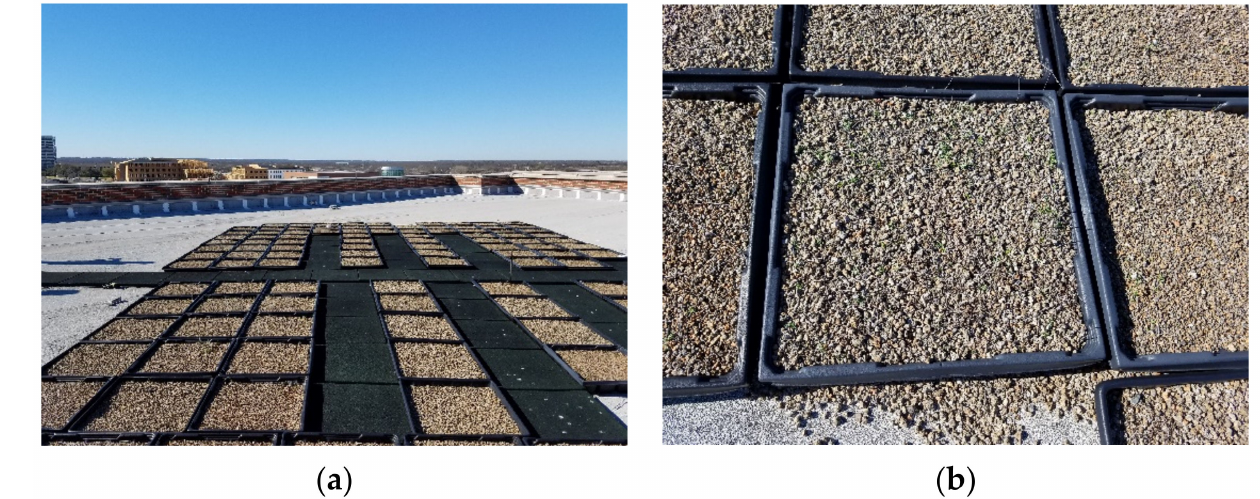
Figure 1. Extensive green roof system: ( a ) system overview; ( b ) individual